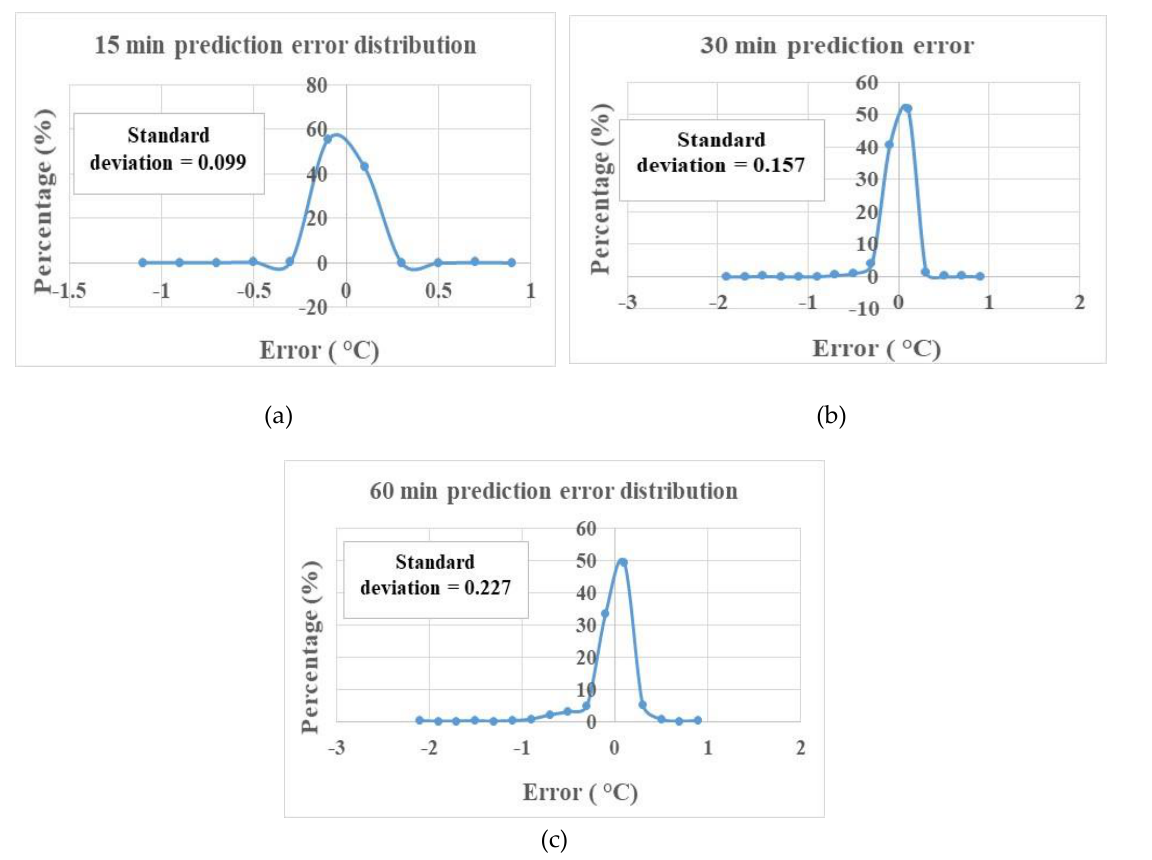
Figure 7. Error distribution for experiment C-order 2: ( a ) 15 min prediction; ( b ) 30 min prediction ( c ) 60 min prediction.